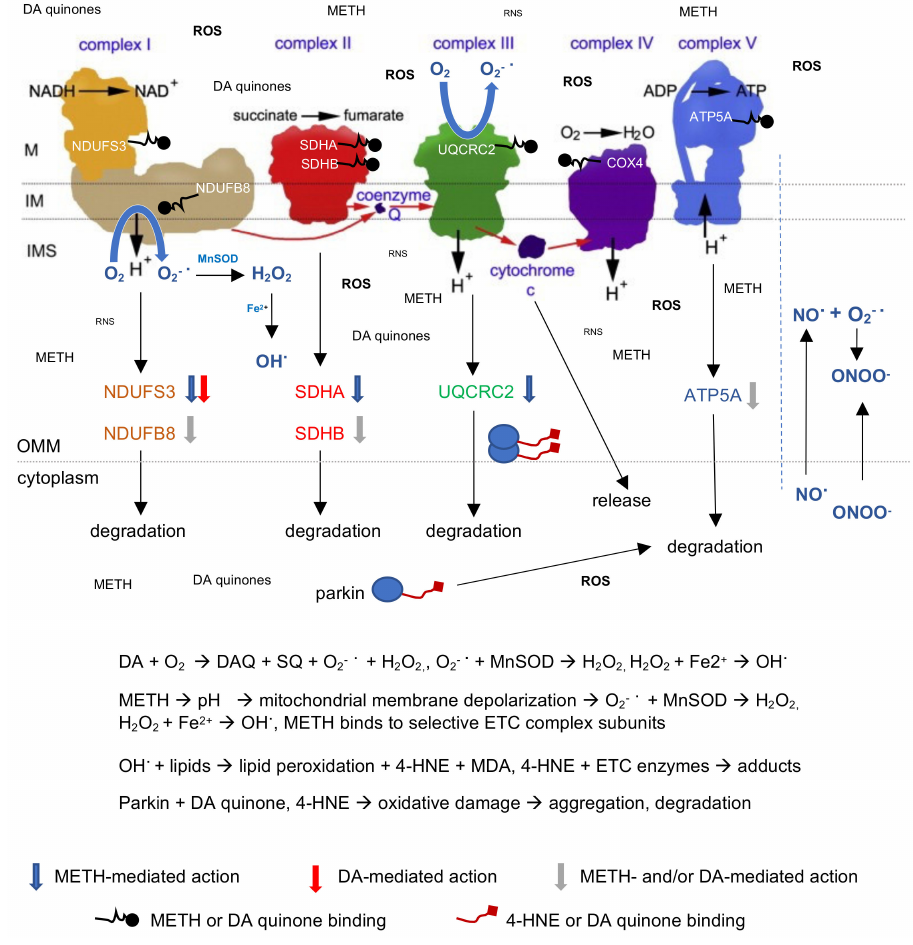
Figure 9. A model of DA and METH effects in cytoplasm-suspended mitochondria, based on our study data and the literature data. Dopamine (DA) autoxidation produces reactive oxygen species (ROS: O 2 − , H 2 O 2 , OH) and DA quinones, which bind to selective electron transport chain (ETC) enzyme subunits and trigger depolarization of mitochondria. Methamphetamine (METH) alkalization of the mitochondrial matrix depolarizes the mitochondrial membrane, leading to production of ROS. METH also binds to selective ETC enzyme subunits. Oxidatively damaged subunits are transported to the cytoplasm for degradation. Mitochondria contain nitric oxide (NO · ), which produces another reactive nitrogen species (RNS), peroxynitrite (ONOO − ), upon reaction with superoxide free radical (O 2 −· ). RNS levels are low compared to ROS levels in vitro because of the absence of glutamate-induced generation of nitric and peroxynitrite (shown right from the dotted line). DA or METH administration triggers a release of cytochrome c. Hydroxyl free radical (OH · ) induces lipid peroxidation with the production of 4-hydroxynonenal (4-HNA) and malondialdehyde (MDA). DA quinone and/or 4-HNE covalently binds to the protein parkin in the cytoplasm, leading to its aggregation and degradation. In mitochondria, aggregated parkin accumulates. Abbreviations: COX4, subunit IV of complex IV; IM, inner membrane; IMS, intramembrane space; M, matrix; mtNOS, mitochondrial nitric oxide synthase; OMM, outer mitochondrial